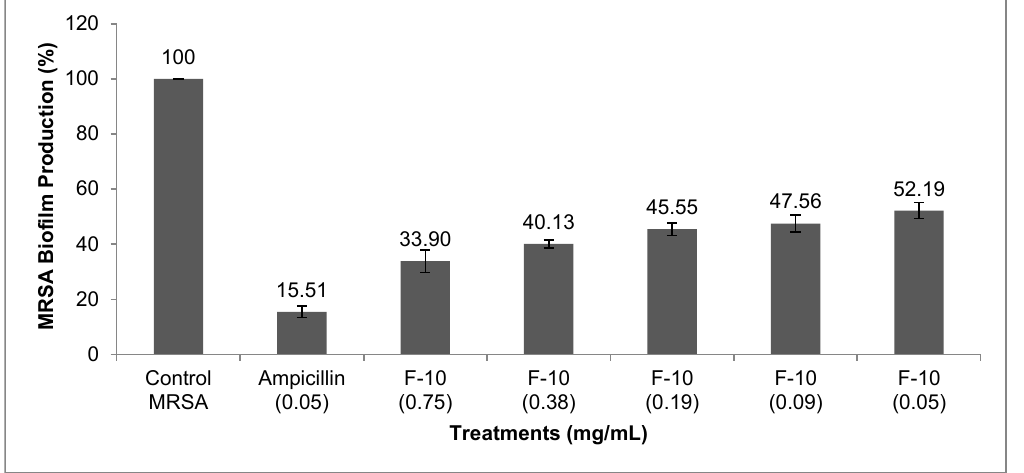
Figure 1. MRSA biofilm formation (%) in microtiter plate wells containing F-10 (mg/mL) treatments. Three wells were used for each treatment. Experiment is representative of three independent tests, and error bars indicate the standard deviation. All difference between control and treated MRSA were statistically significant ( p < 0.001).